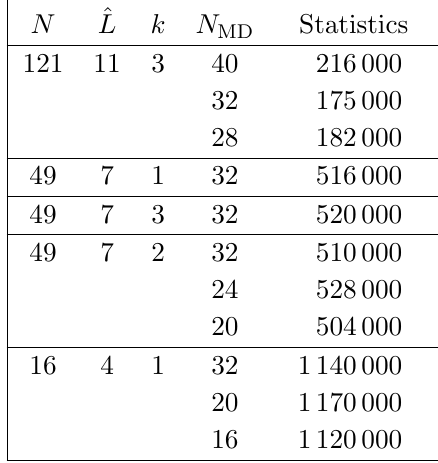
Table 1. Simulation parameters and